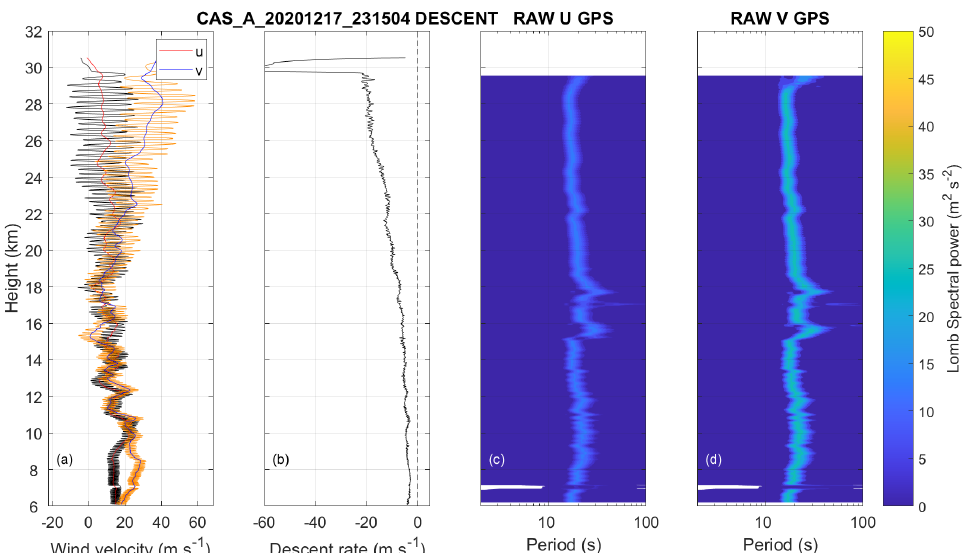
Figure 9. Vertical profiles of (a) processed horizontal wind components u and v in solid red and blue for respectively with raw GPS winds in black and orange for the u and v components respectively, and (b) descent speed. Panels (c) and (d) show Lomb periodograms of the detrended raw GPS velocities as a function of height for a sounding made at Castor Bay autosonde station (54.50 ◦ N, 6.34 ◦ W) at